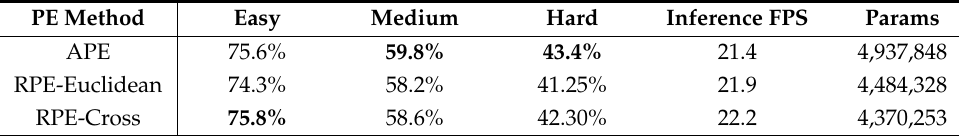
Table 3. Ablation study on the positional encoding